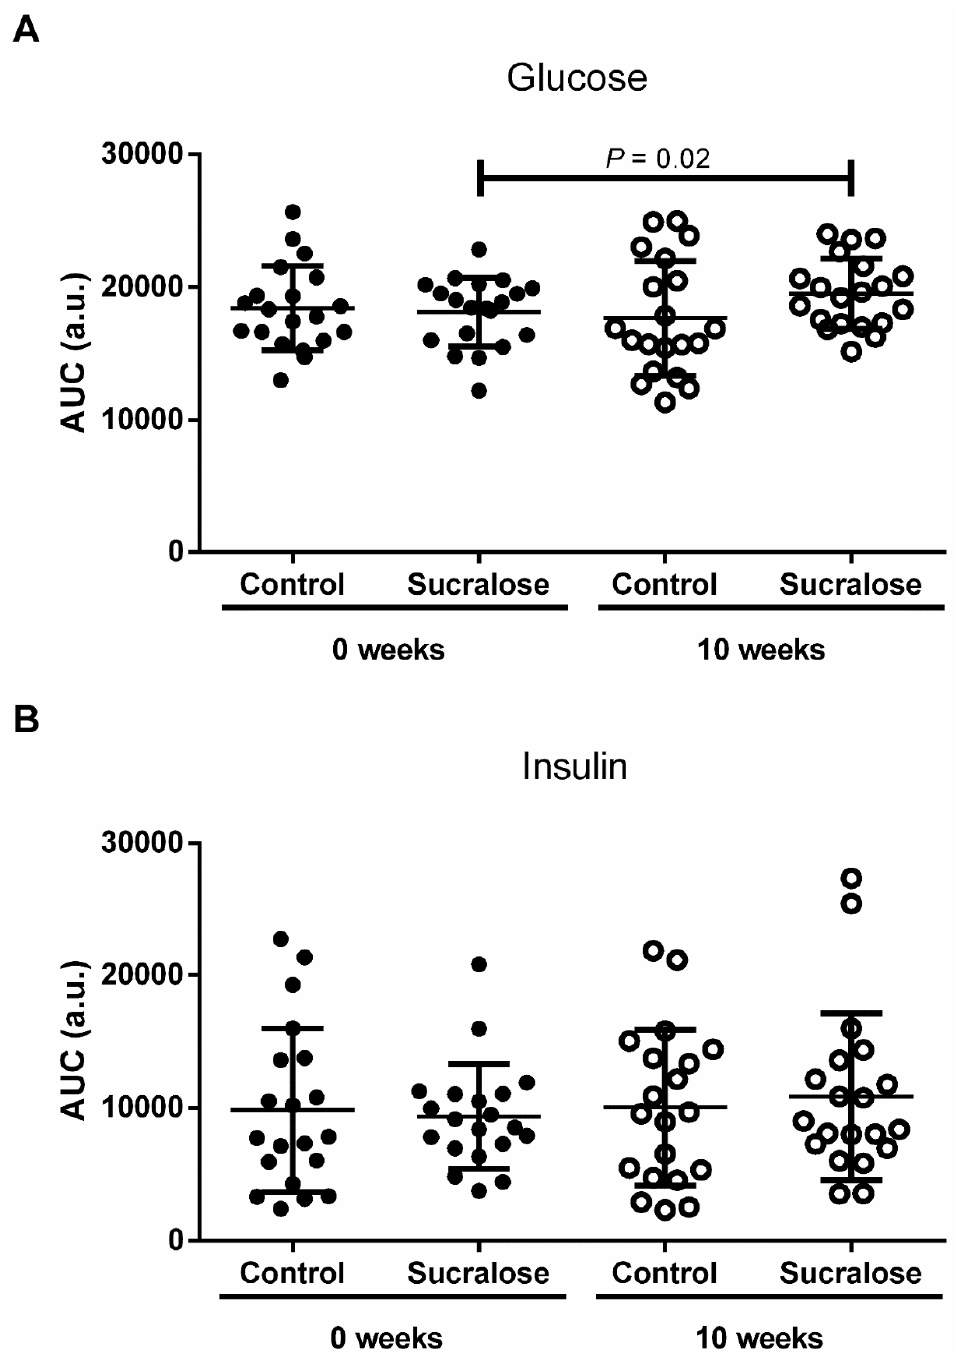
Figure 3. The area under the curve of glucose and insulin during the oral glucose tolerance